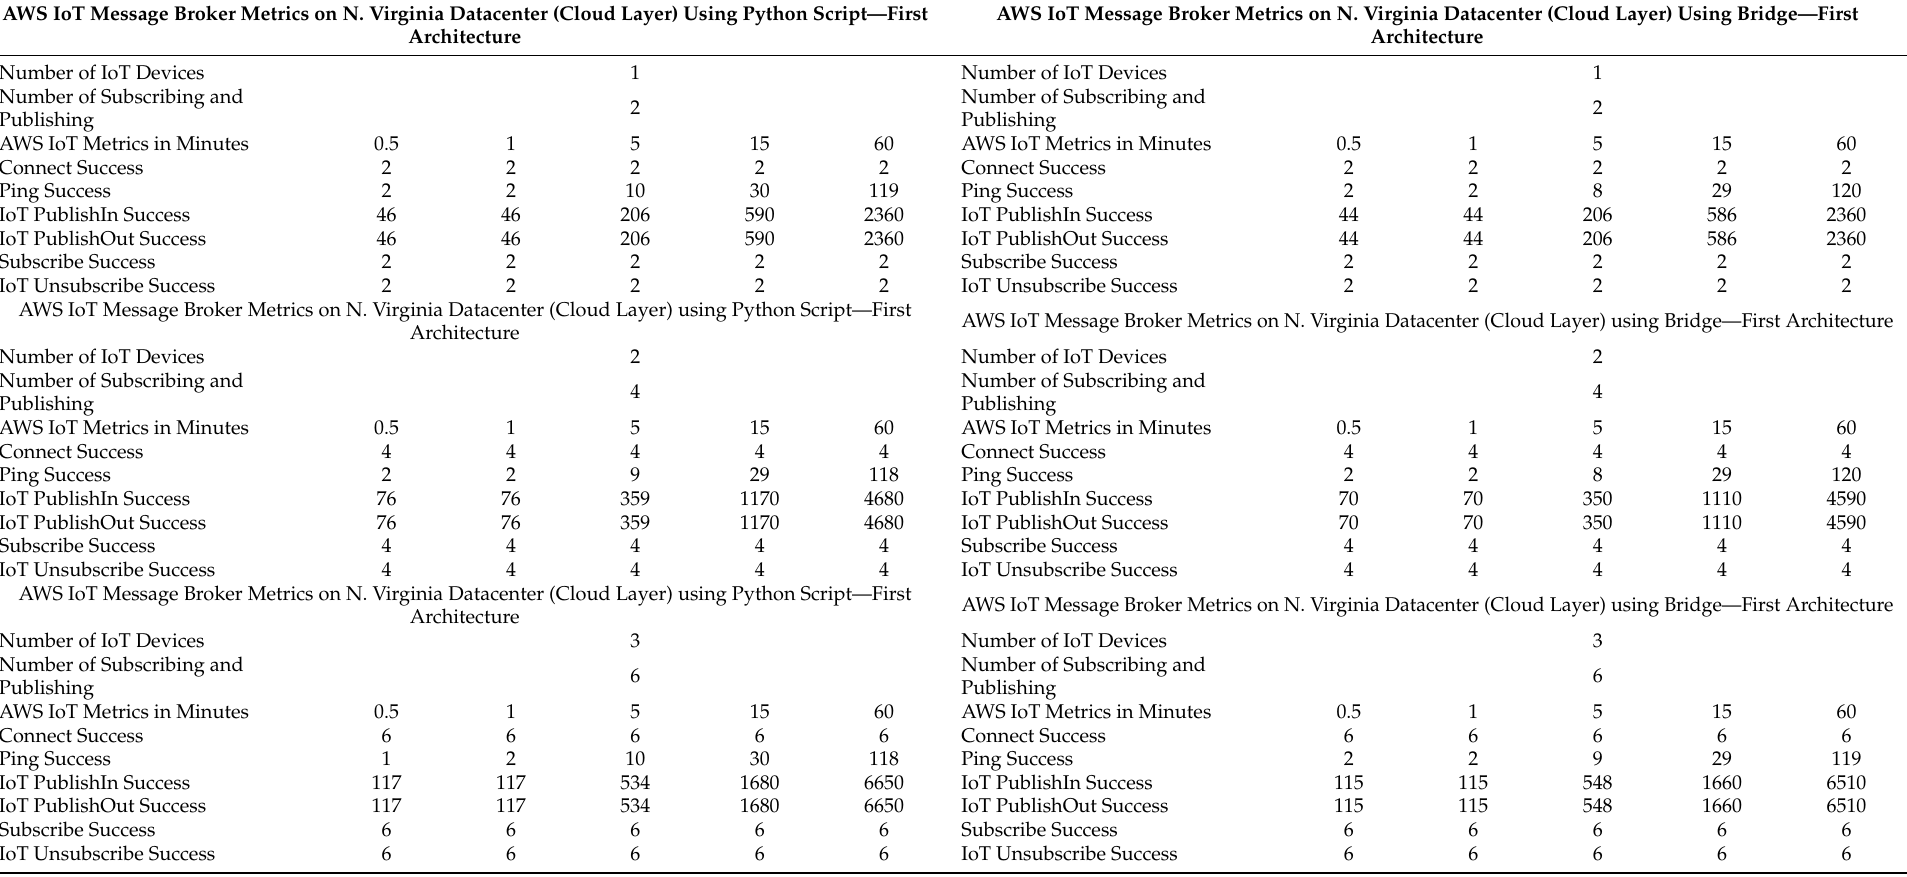
Table 3. AWS IoT message broker metrics on North Virginia datacenter (cloud layer) using a bridge vs. Python—first